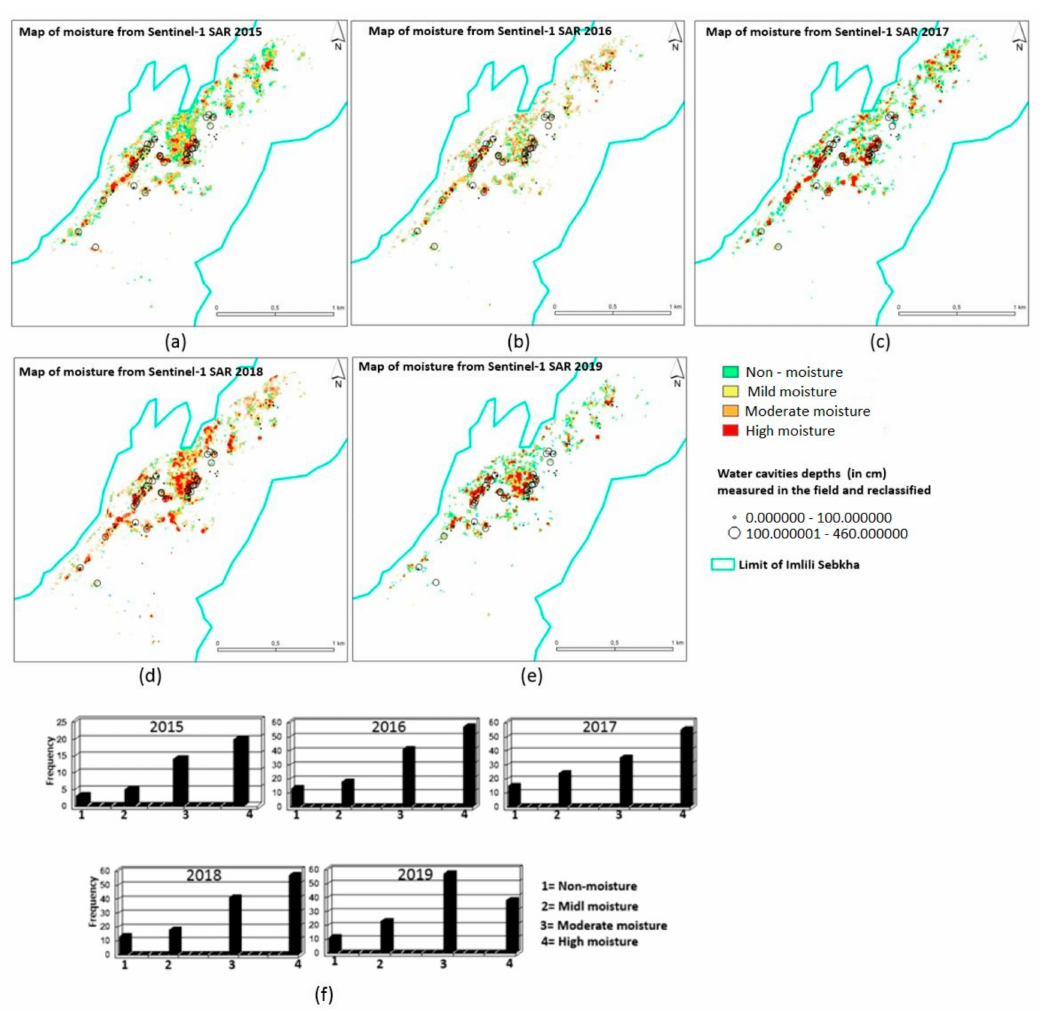
Figure 9. ( a – e ) Moisture map obtained from the reclassification of the MNDPI signal into four classes from non-moisture to high moisture of the water holes from 2015 to 2019 versus the depth of the saltwater cavities measured in the field and reclassified into two classes, and ( f ) moisture state statistics of the saltwater cavities extracted from